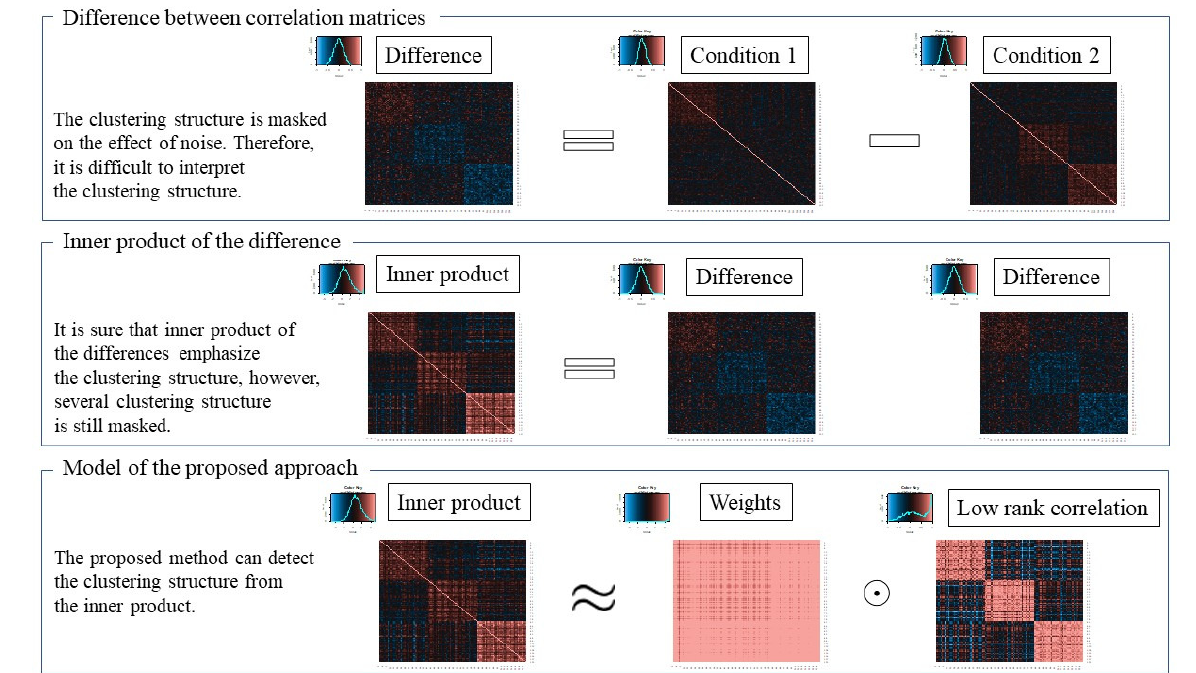
Figure 1. Image of proposed